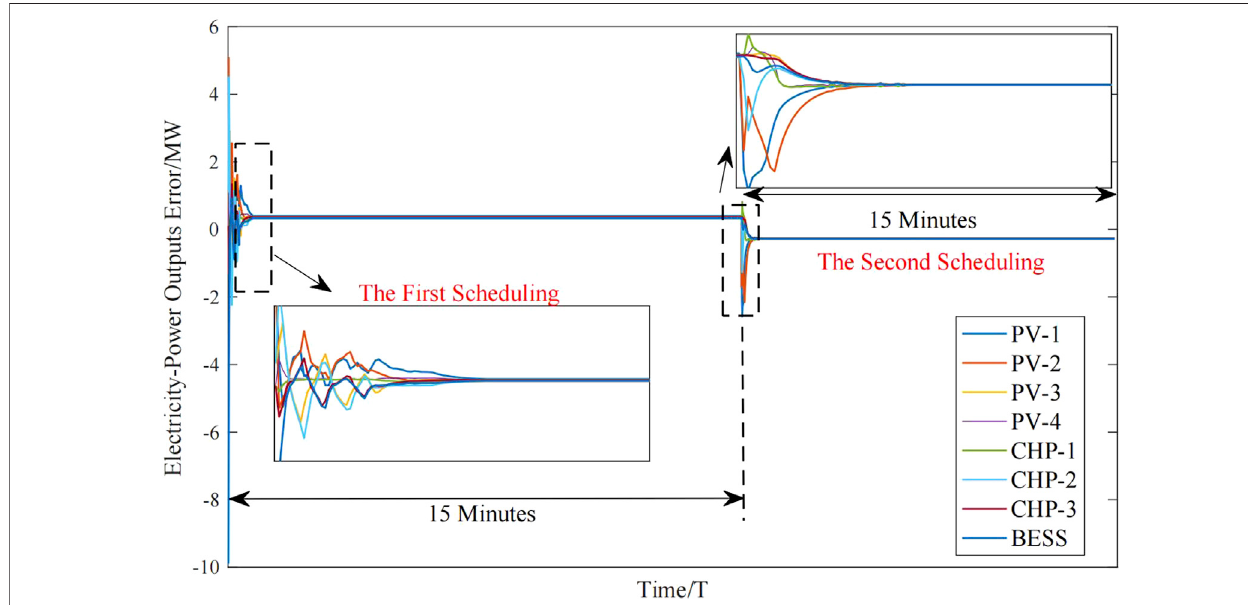
FIGURE 7 | Electricity-power outputs error on generators.